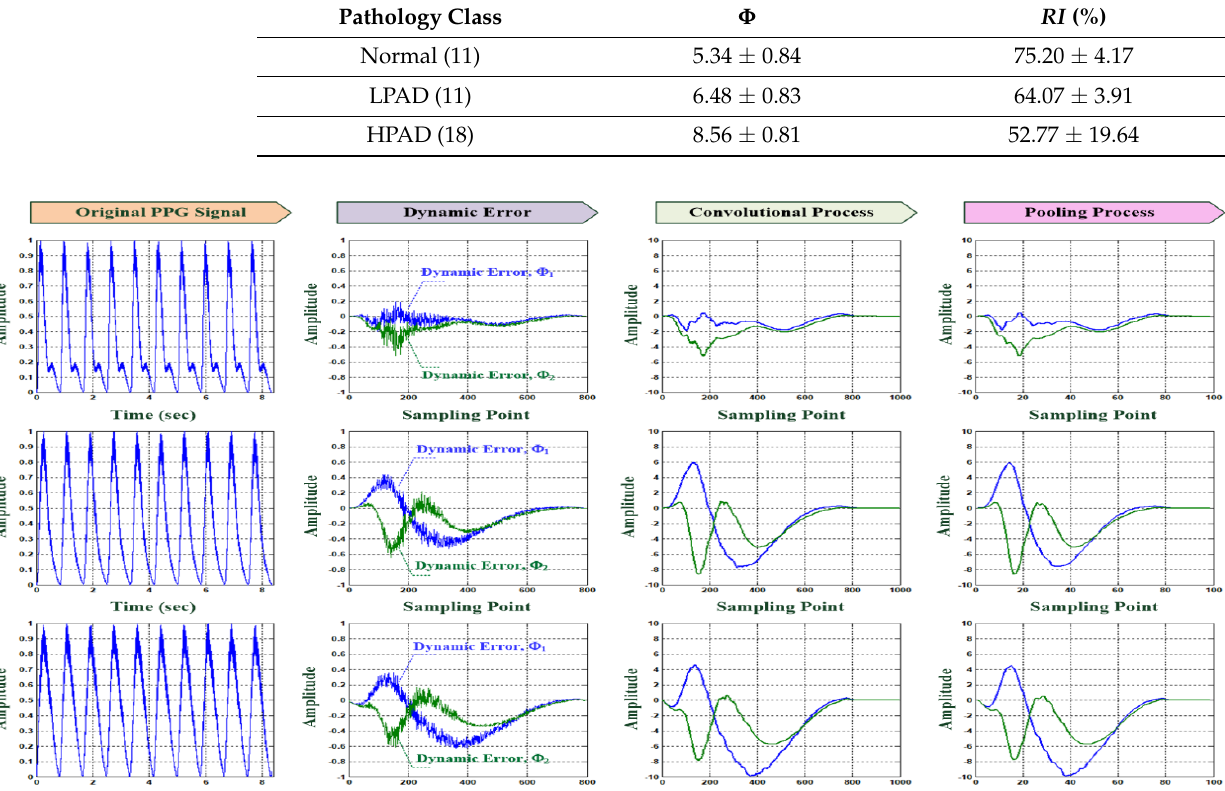
Table 2. Related data of 1D CNN-based multilayer classifier.